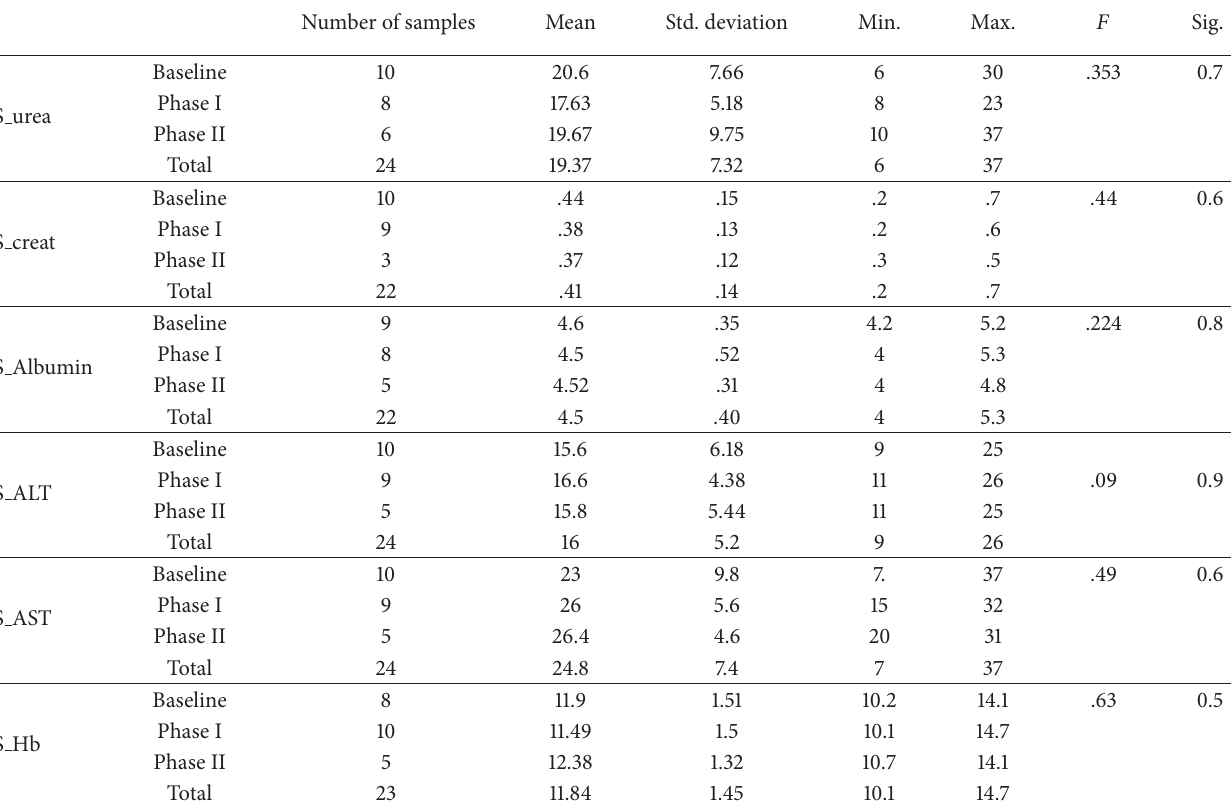
Table 2: Levels of follow-up laboratory parameters in all phases. Number of samples Mean Std. deviation